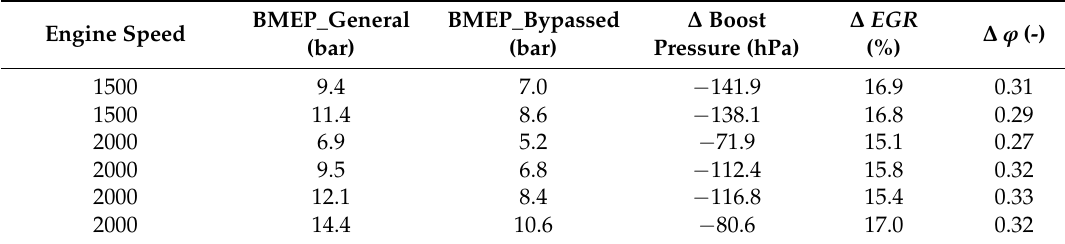
Table 5. Major engine operating parameter changes in the selected general vs. the bypassed operating conditions. The injection strategy used was identical in for conditions ( ∆ : based on nominal value).